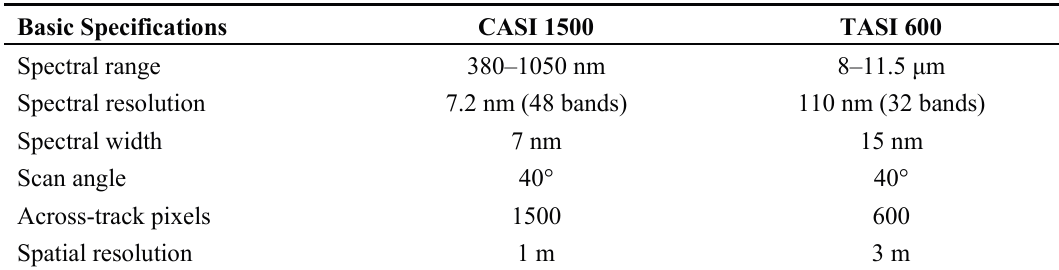
Table 2. Basic specifications of